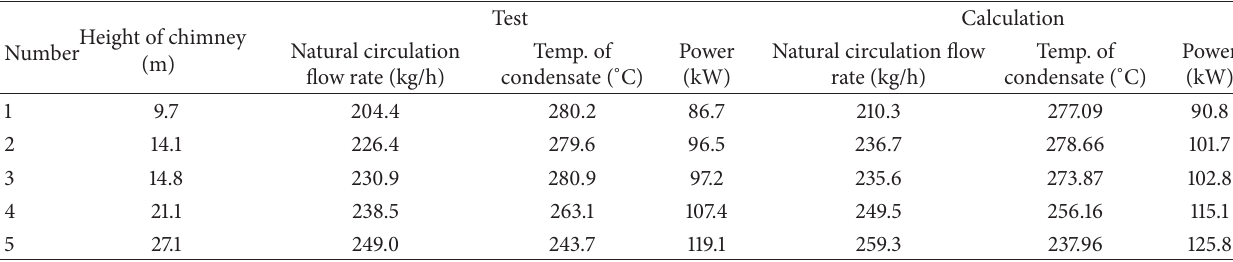
Table 1: Effect of the height of chimney.